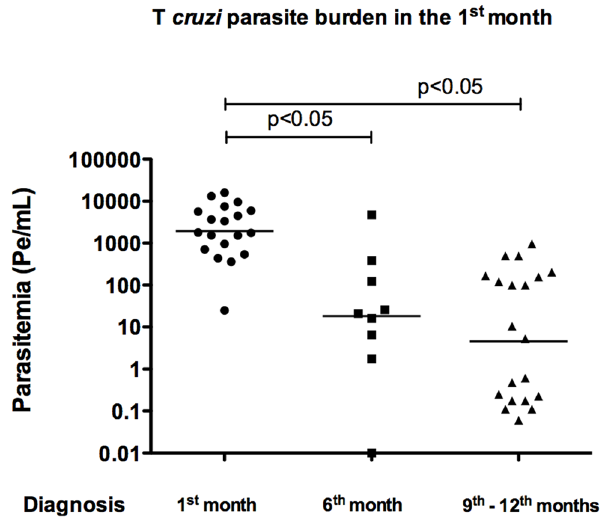
Figure 2. T. cruzi bloodstream parasite burden in newborns tested at their first month of age. In T. cruzi infected children diagnosed in their first, second or third control, at 1, 6 months of age and around 1 year old, repectively, parasitemia was quantified by qPCR in the sample obtained at the 1 st month of age. Significant differences were found in the median of the three groups assayed, by Kruskal– Wallis test using GraphPad Prism 5 software.